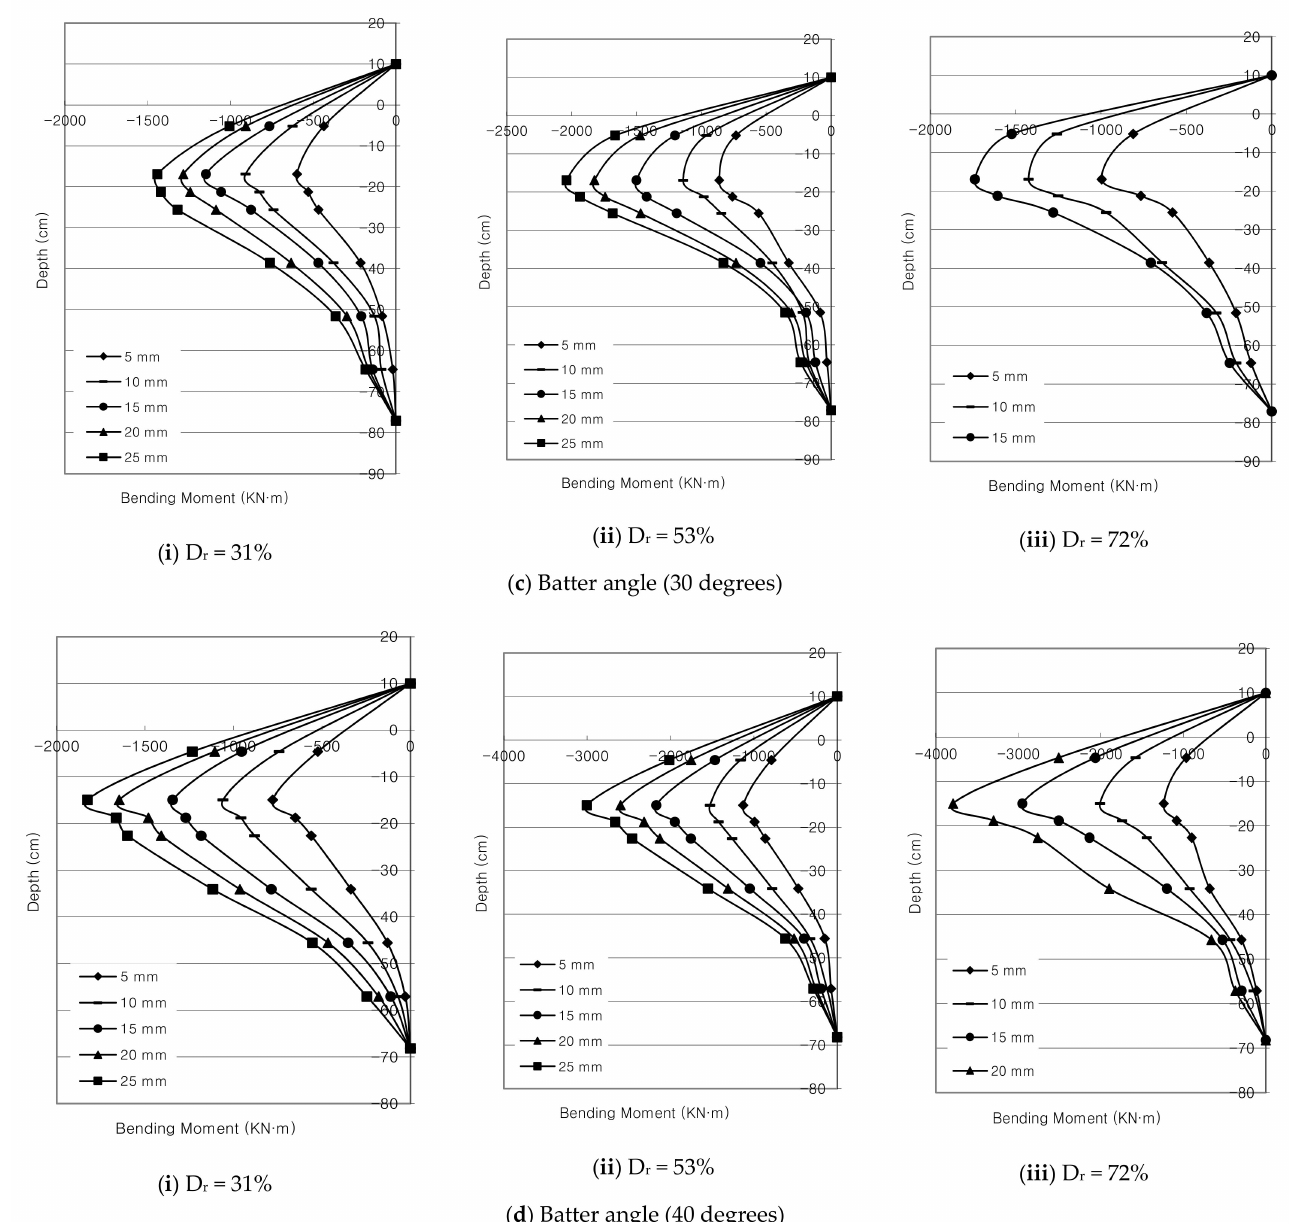
Figure 12. Relation of pile head displacement and bending